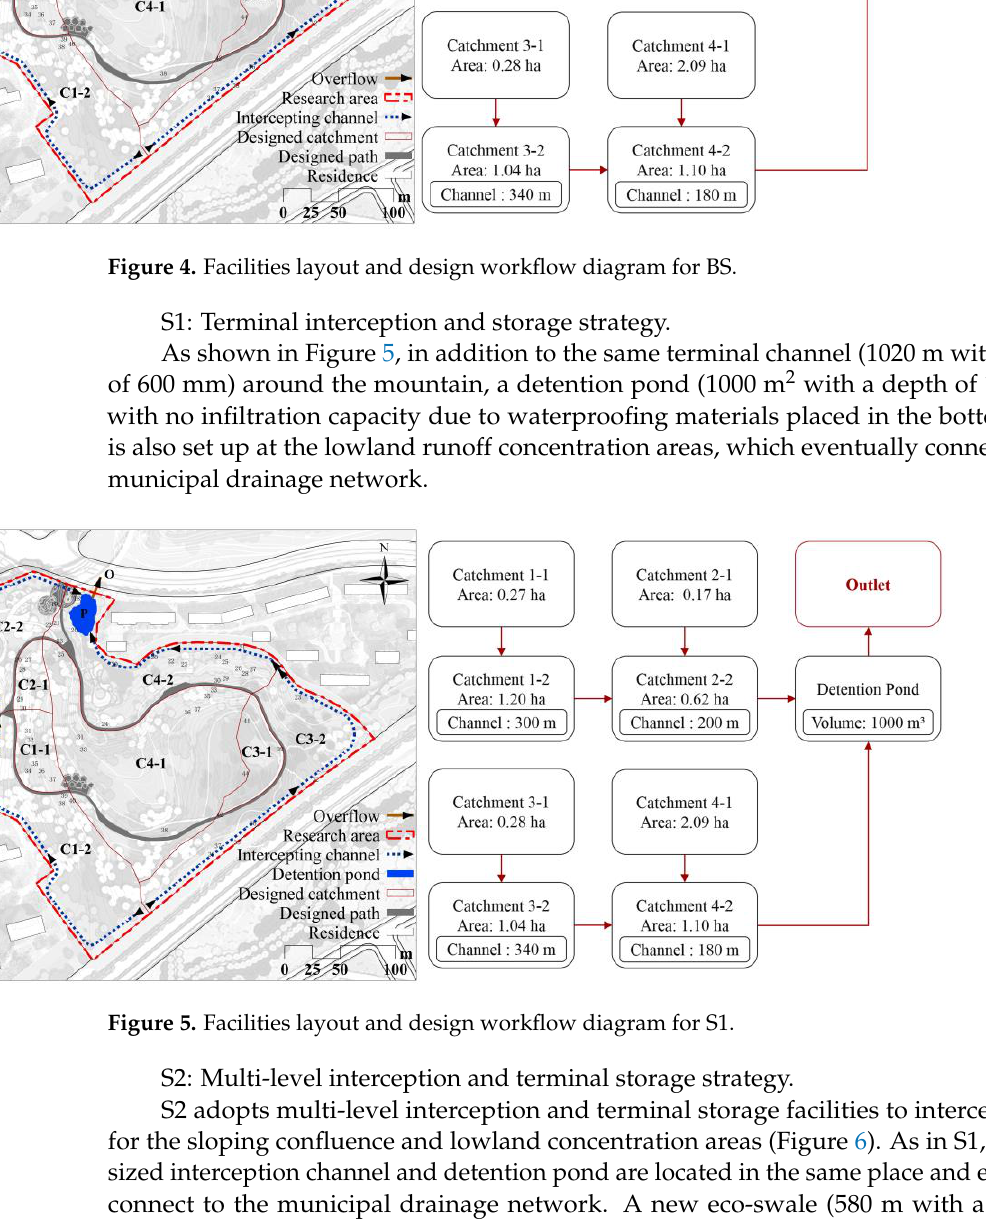
Figure 6. Facilities layout and design workflow diagram for S2. S3: Multi-level interception and storage strategy (The total storage volume stays as S2). S3 adopts multi-level interception and storage facilities to intercept and retain run- off for the sloping confluence and lowland concentration areas (Figure 7). The eco-swale and terminal interception channels are the same as in S2. However, the detention pond in S2 is divided into two levels (P1, P2) with the same total volume. P1 and P2 are pro- portional to their catchment area. P1 (400 m 2 with a depth of 1000 mm) holds the up- stream runoff from the eco-swale, and P2 (600 m 2 with a depth of 1000 mm) holds the entire upstream runoff. This strategy provides a new multi-level storage facility to com- pare S1 and S2 under the same storage volume situation.